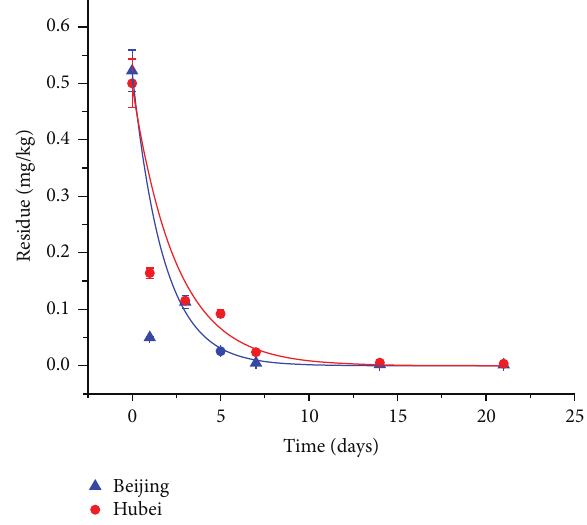
Figure 2: The dissipation curves of thifluzamide in paddy water in Beijing and Hubei (2014).